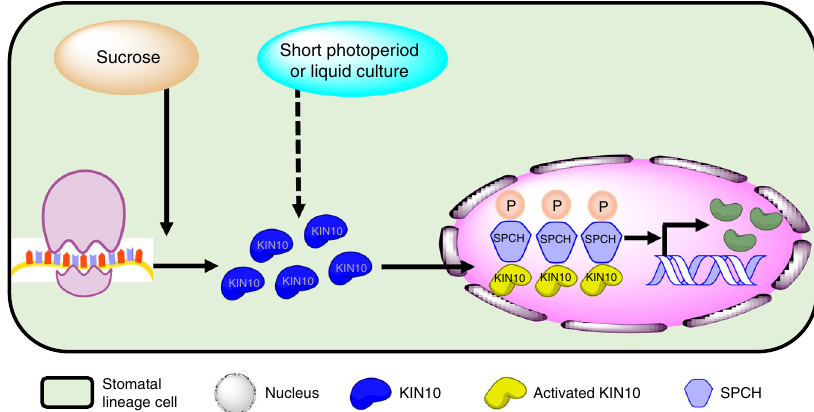
Fig. 6 A model for KIN10-promoted stomatal development through phosphorylation and stabilization of SPCH. When plants were grown under conditions that are likely associated with mild energy starvation of plants, such as short photoperiod or liquid cultures, sucrose supply induced the KIN10 protein accumulation by increasing its translation. KIN10 displayed the cell-type-speci fi c subcellular location pattern in the epidermal cells of leaves. The nuclear-localized KIN10 in stomatal-lineage cells phosphorylated and stabilized SPCH to promote stomatal development. Thus, the combination of multiple regulatory mechanisms controls the activity of KIN10 and thereby optimizes stomatal